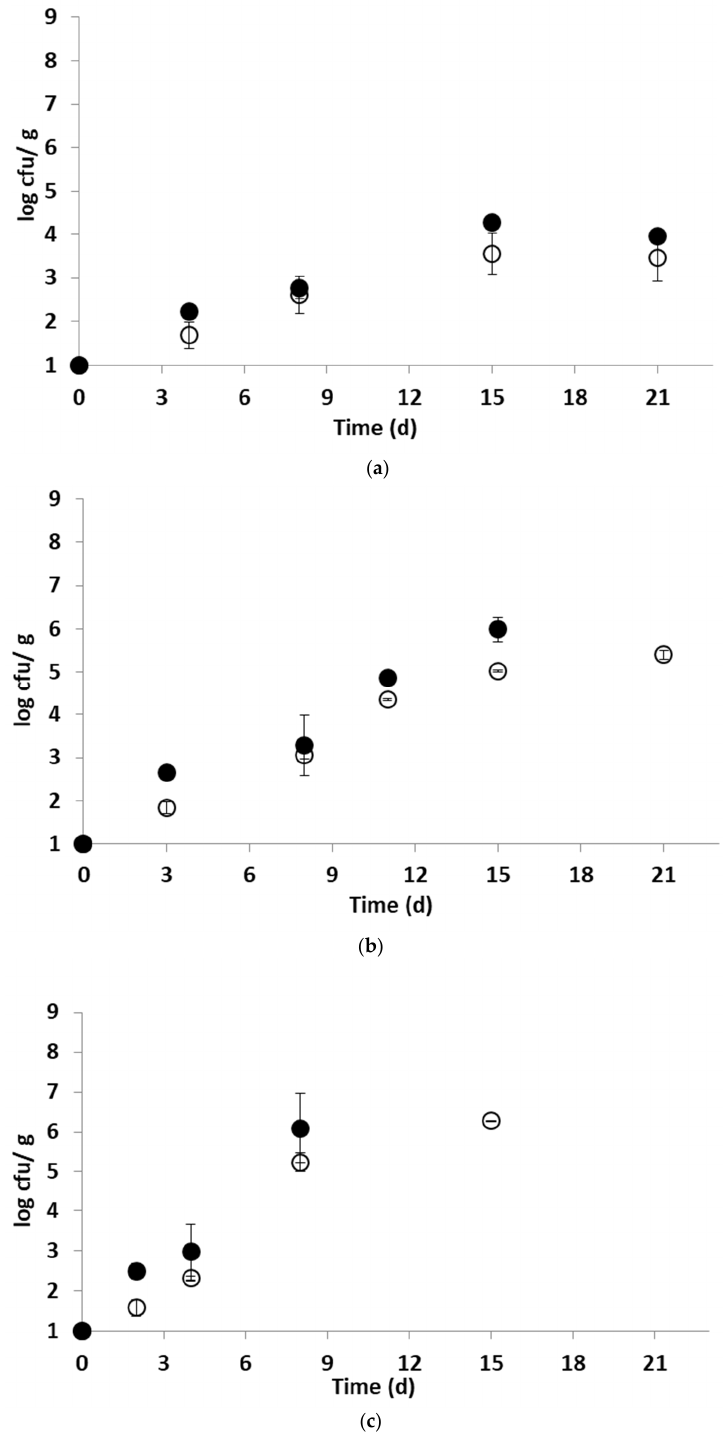
Figure 5. Enterobacteriaceae spp. count in MAP and ACT-MAP sea bass during the isothermal storage at ( a ) 0 °C, ( b ) 5 °C, and ( c ) 10 °C ( ○ ACT-MAP, ● MAP).